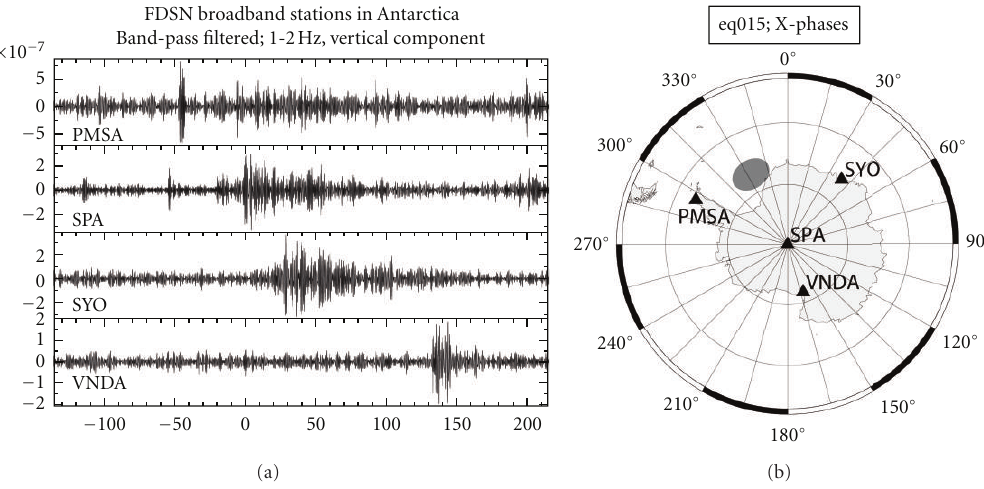
Figure 16: (left) Comparison of the X-phases (event#; eq015) recorded by four existing FDSN stations in Antarctica (from top to bottom; PMSA, SPA, SYO, and VNDA). All waveforms are band-pass filtered (1.0-2.0Hz) vertical component. (right) Location of the four FDSN stations. Shaded ellipse indicates a possible source for the energies in the waveforms as the